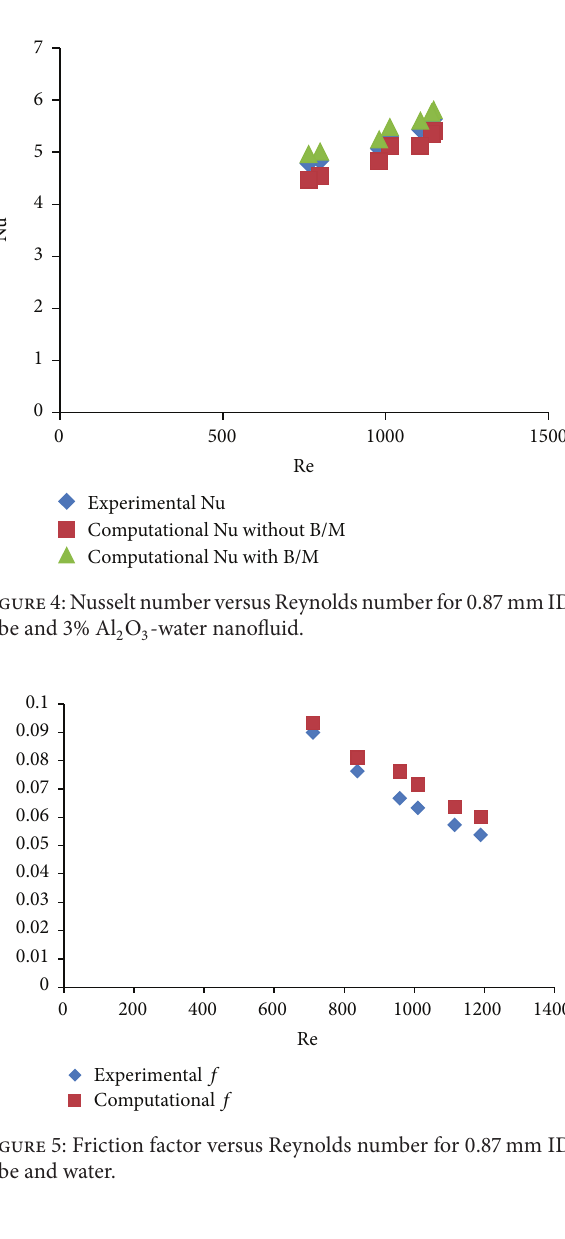
Figure 3: Nusselt number versus Reynolds number for 0.87 mm ID- tube and 2% Al 2 O 3 -water nanofluid.